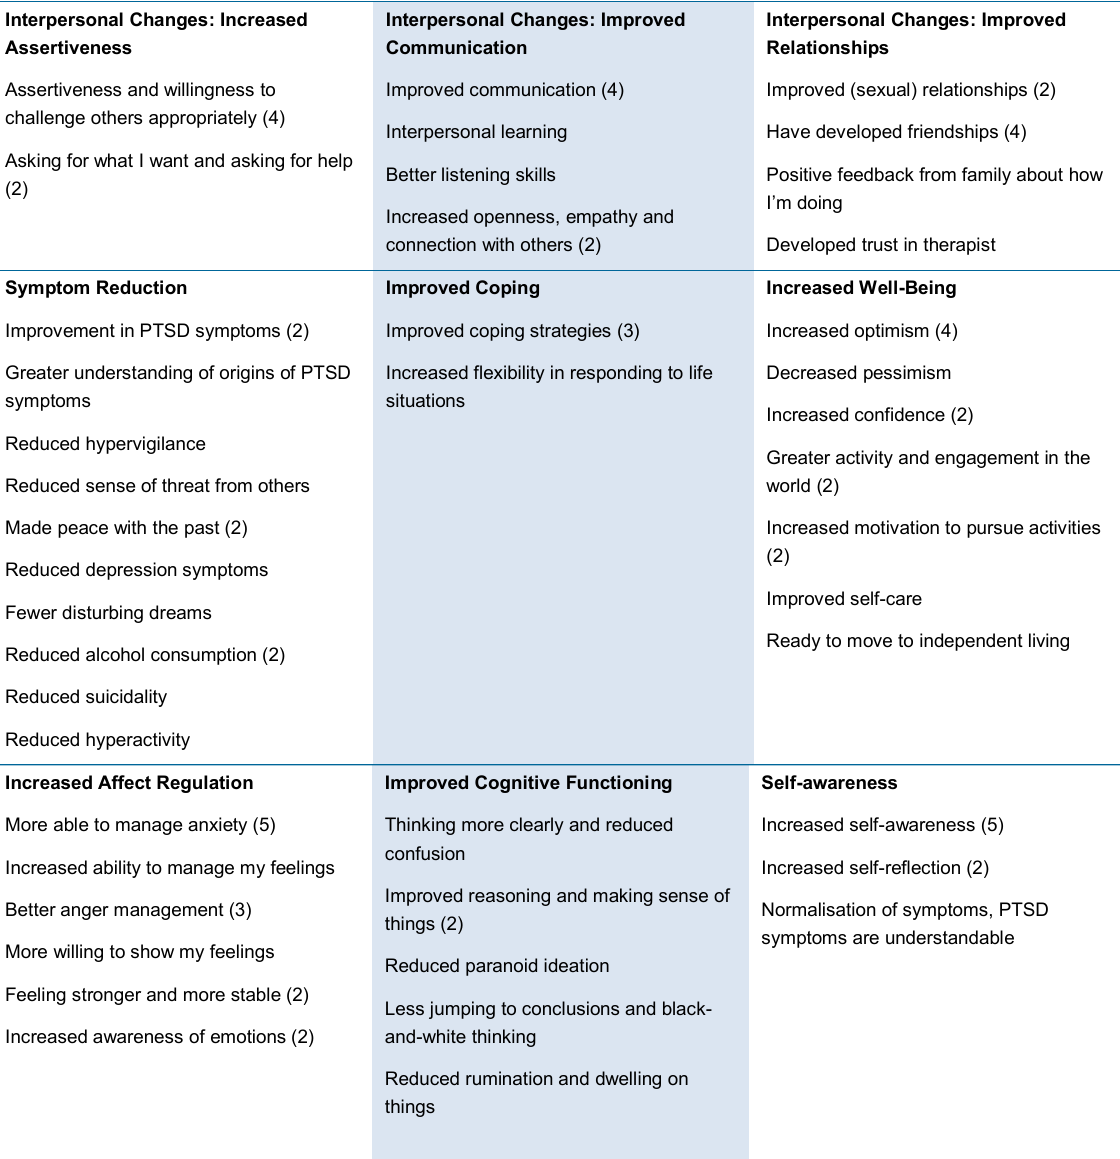
Table 13: Conceptual Categories of Change for 8 Veterans' Change Interview Responses (after Braun & Clarke, 2006)